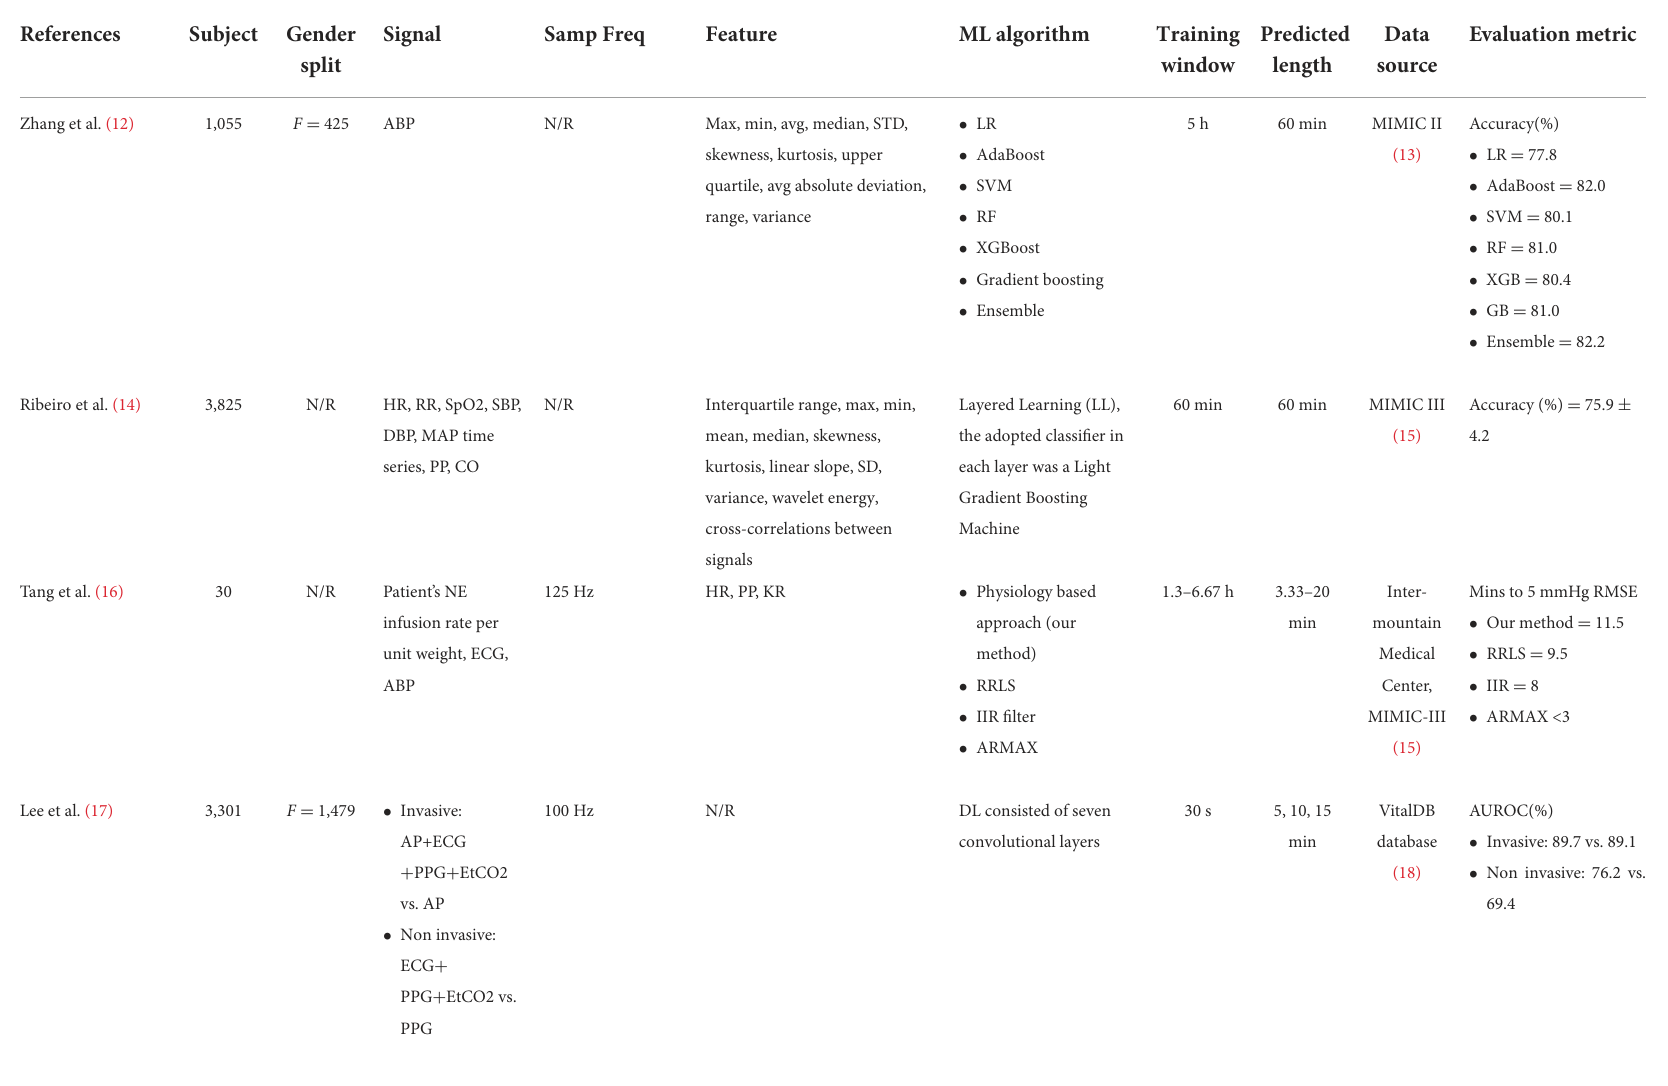
TABLE 1 Overview of studies included in the systematic